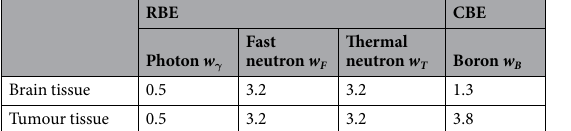
IAEA-TECDOC-1223 BNCT treatment planning protocol 52 : each physical dose component (apart from the